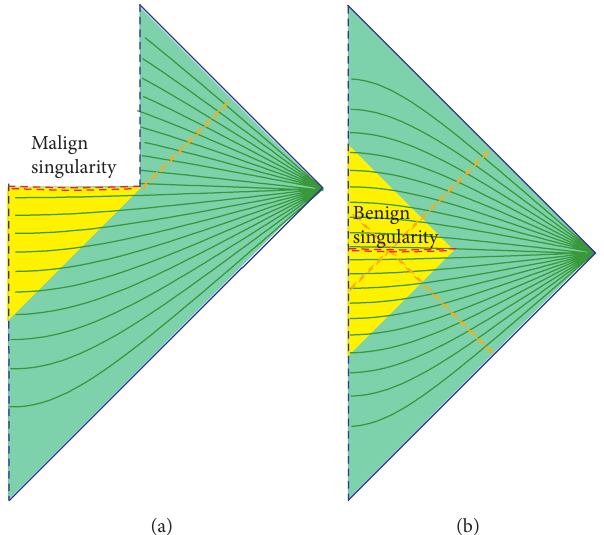
Figure 4: (a) Standard evaporating black hole, whose singularity destroys the information. (b) Evaporating black hole extended through the singularity preserves information and admits a space + time